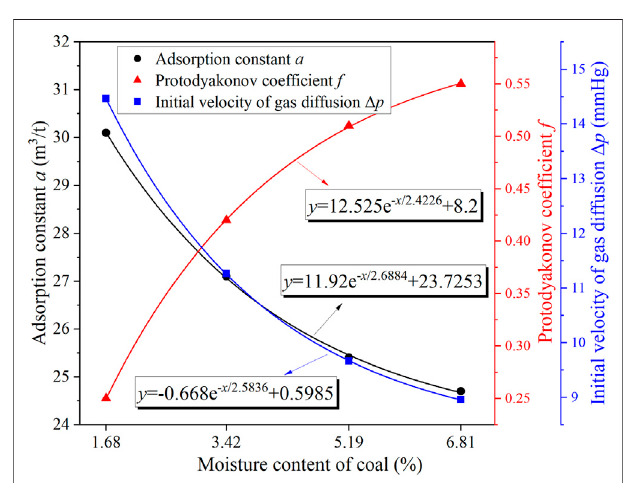
FIGURE 3 | Variation law of the gas outburst parameters with moisture